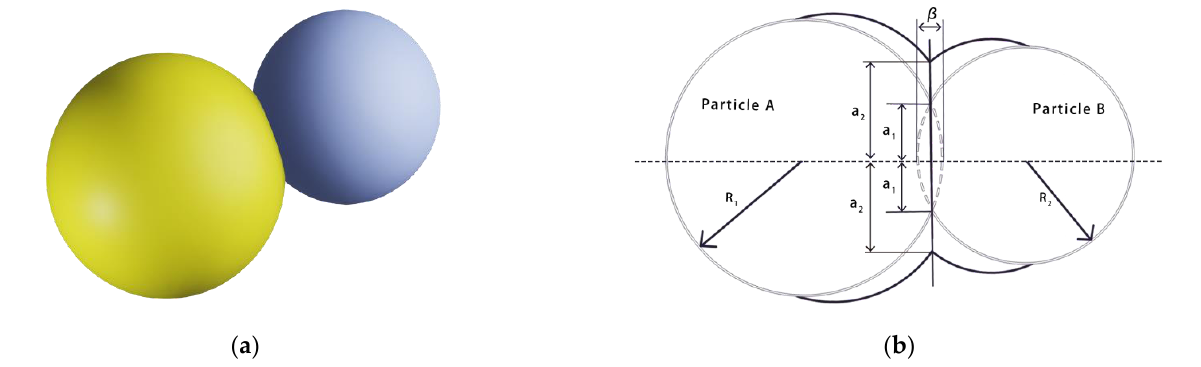
Figure 1. Particle model ( a ) and JKR contact theory bonding diagram between particles ( b ).